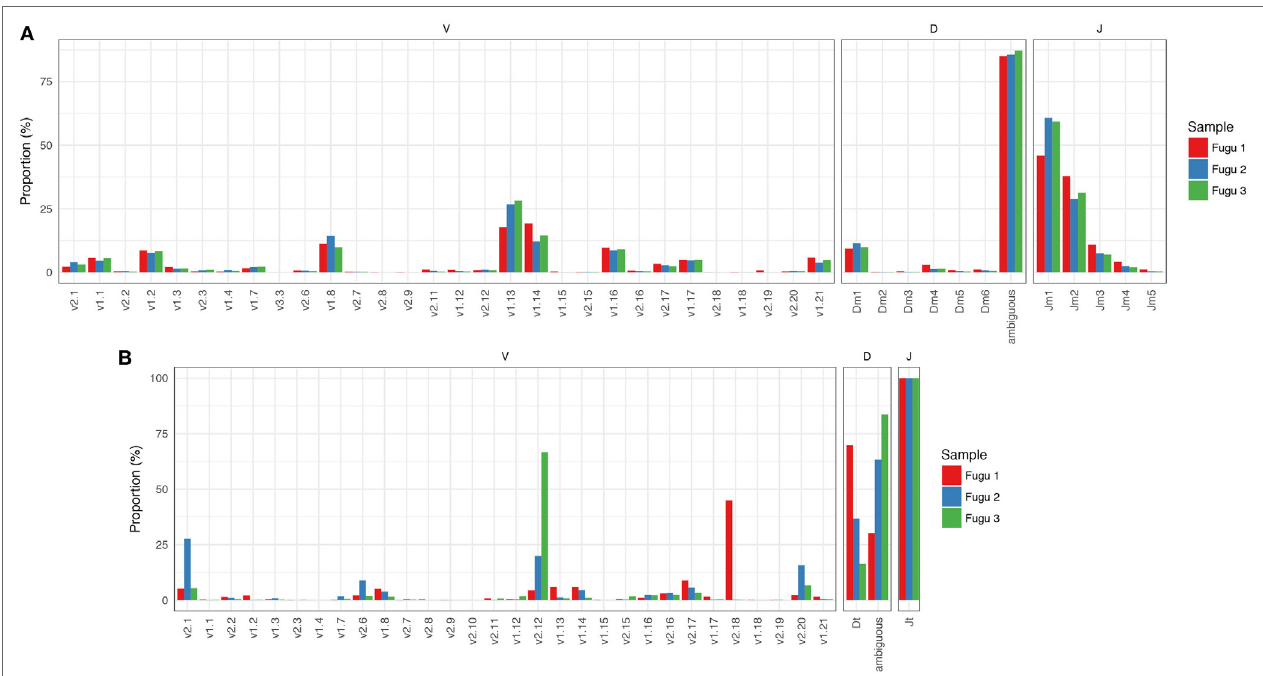
FigUre 1 | Overall IgM (a) and IgT (b) repertoires across the three torafugu. Non-uniform usages of V, D, and J gene segments were observed. VDJ gene segments are presented in 5 ′ to 3 ′ order as in genomic